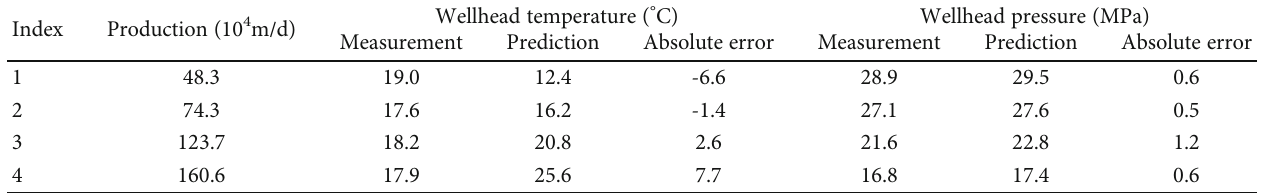
Table 2: Comparison of the calculated temperature and pressure with the fi eld